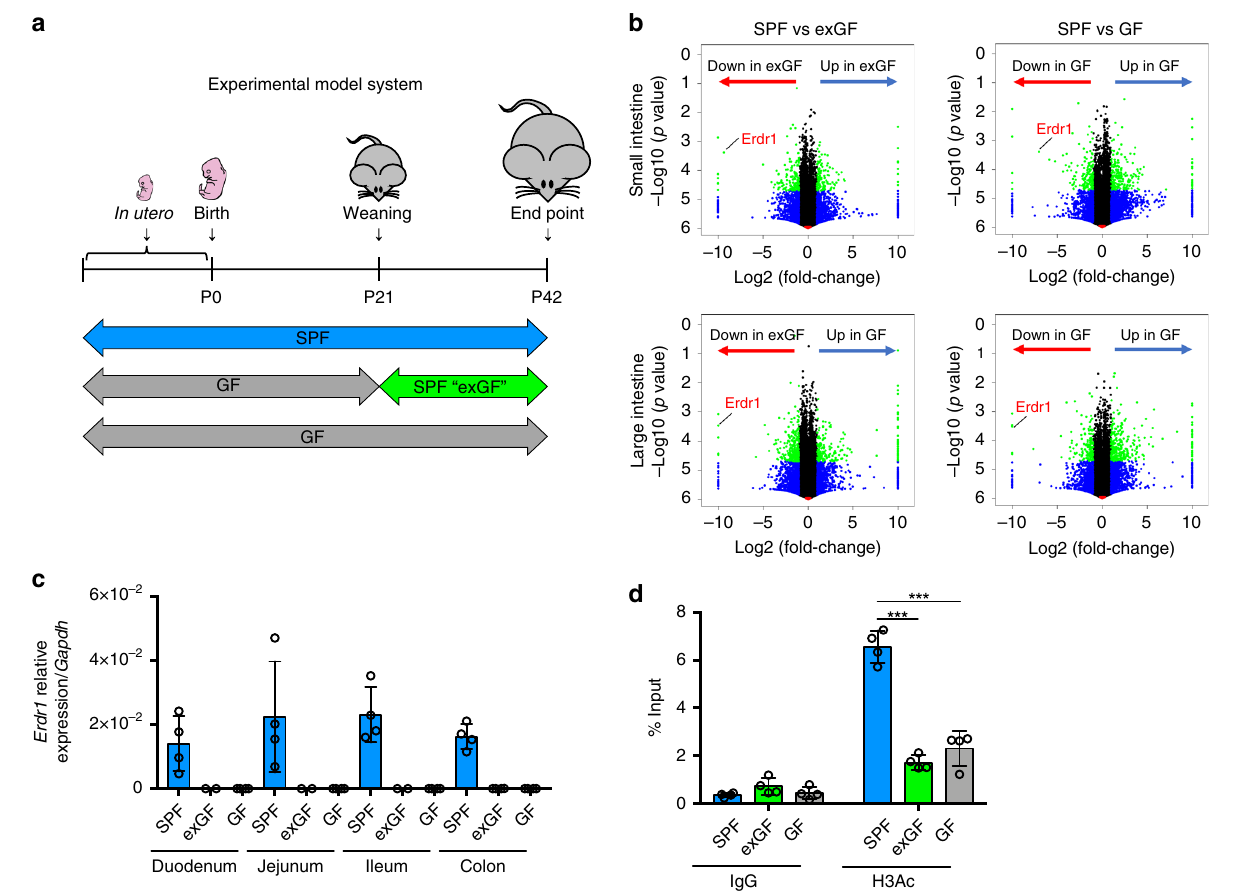
Fig. 1 Early-life microbiota regulates Erdr1 expression. a Experimental schematic of the exGF model: Germ-free (GF) mice were colonized with microbiota beginning at day 21 by co-housing with SPF mice for 3 weeks. b Volcano plots showing log2 fold-change of total colon gene expression in SPF mice compared with exGF or GF mice. Genes that were signi fi cantly decreased in exGF or GF compared with SPF colons are highlighted on red, while those increased in exGF or GF are highlighted in blue. c qPCR analysis of Erdr1 using whole small and large intestinal tissue from SPF, exGF, and GF mice. n = 2 (duodenum/jejunum/ileum from exGF), n = 4 (duodenum/jejunum/ileum from SPF and GF, colon). d ChIP analysis for histone H3 acetylation (H3Ac) in the Erdr1 promoter region using total colon tissue. n = 4; two independent experiments. All data are presented as mean ± SD; * P < 0.05, ** P < 0.01, *** P < 0.001 by one-way ANOVA with Tukey ’ s multiple comparison